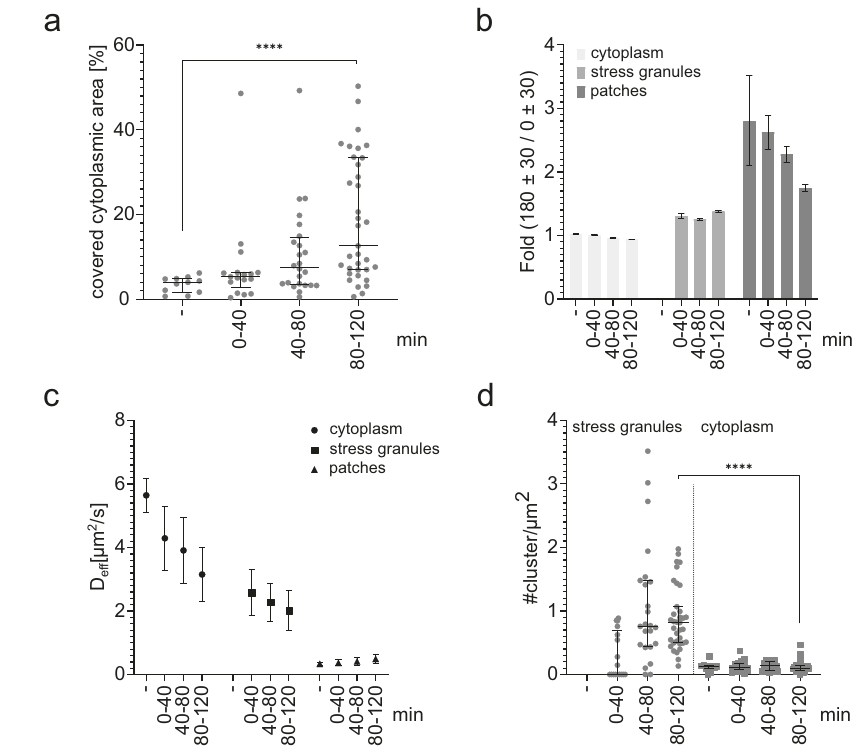
Fig. 7 | Quanti fi cation of cytoplasmic TDP-43 patches and TDP-43 localization hotspots. a Analysis of the cytoplasmic area covered by the patches at unstressed and different stress conditions, showing a signi fi cant increase of patch-covered cytoplasmic area with stress (stat. test: two-tailed Mann − Whitney, p -value= <0.0001, data are displayed as the median +/ − the interquartile ranges). b Anisotropy analysis of TDP-43 Halo molecules located in the cytoplasm (outside of cytoplasmic patches), stress granules and cytoplasmic patches at unstressed and different stress conditions. Values are displayed as the mean +/ − the STD from 50 resamplings performed with 50% of the data. c Diffusivity analysis of TDP-43 Halo molecules located in the cytoplasm (outside of cytoplasmic patches), in stress